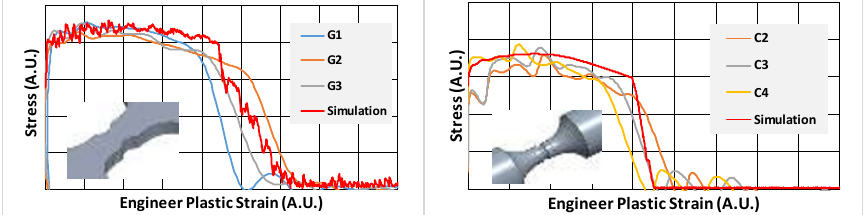
Fig. 7. Comparison between simulations and SHTB tests with various triaxiality levels